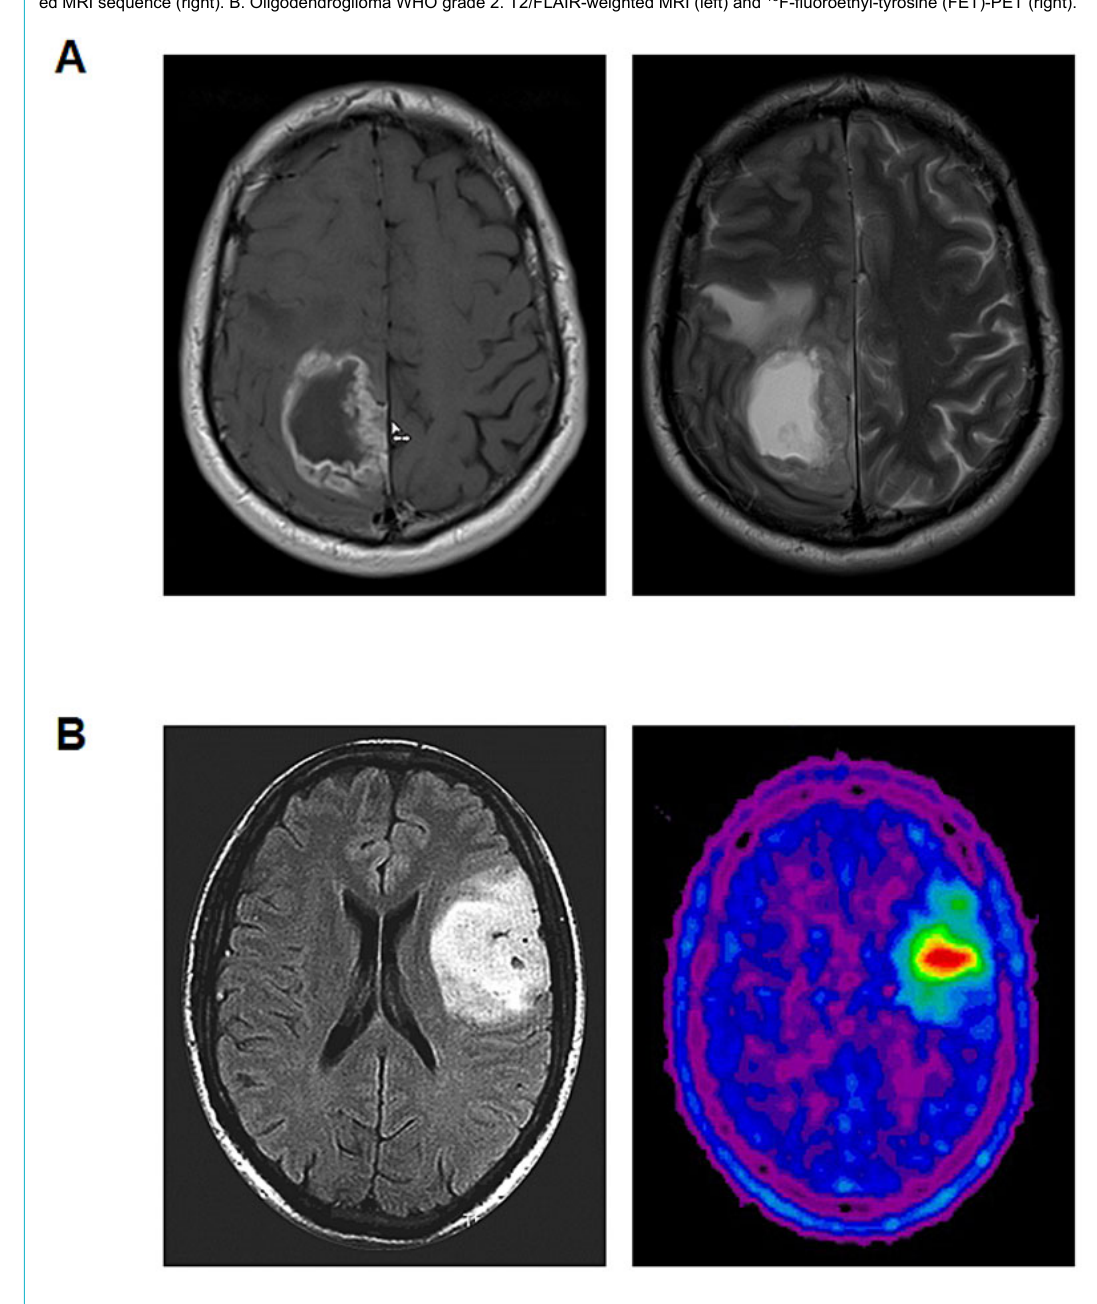
Figure 1: Representative imaging findings in glioma patients. A. Glioblastoma. T1-weighted contrast-enhanced MRI (left) and T2-weight- ed MRI sequence (right). B. Oligodendroglioma WHO grade 2. T2/FLAIR-weighted MRI (left) and 18 F-fluoroethyl-tyrosine (FET)-PET